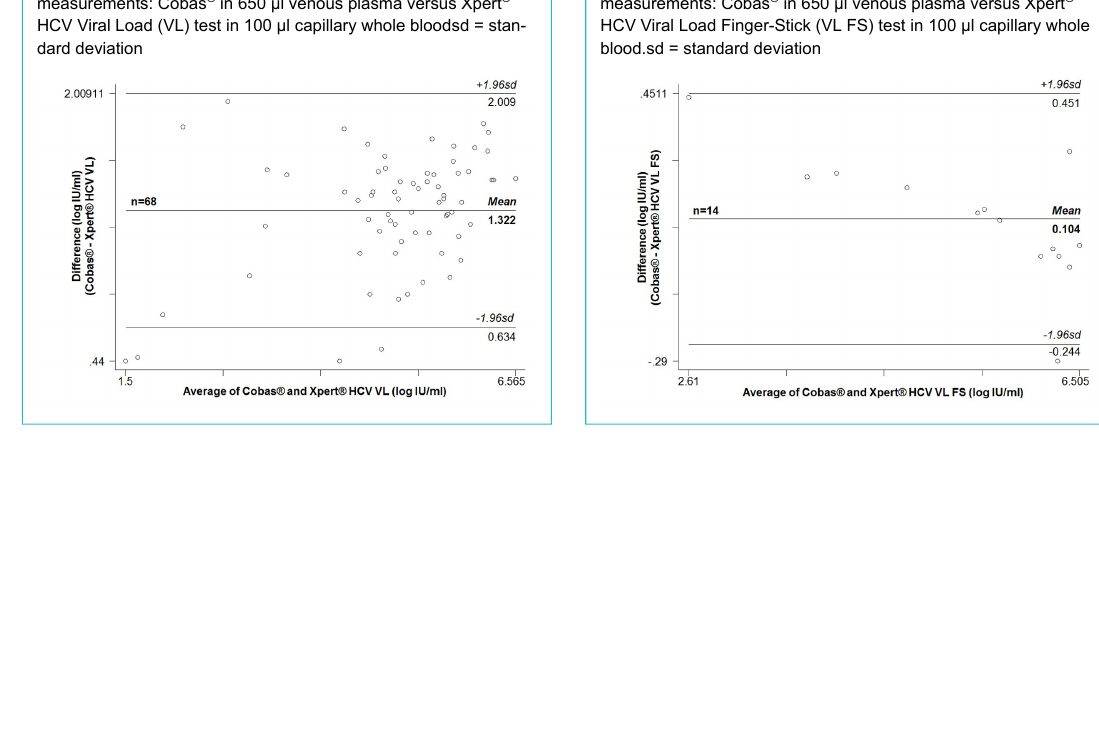
Figure S1: Bland-Altman plot of 68 paired quantifiable HCV RNA measurements: Cobas ® in 650 µl venous plasma versus Xpert ®